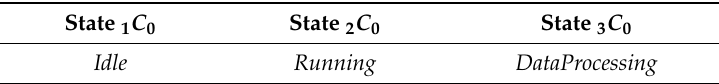
states C (cid:96) 0 0